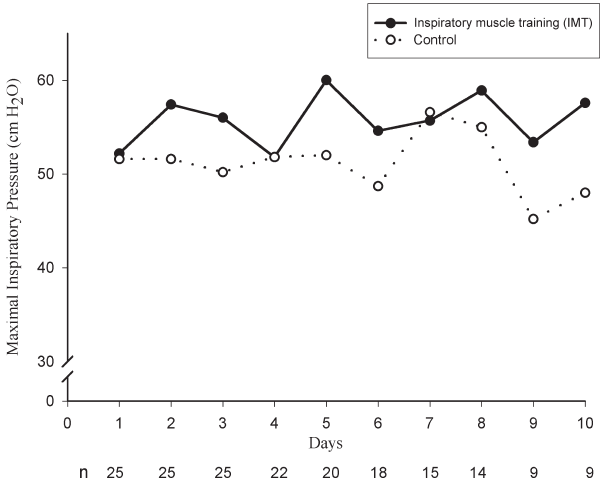
Figure 1 - Daily evolution of maximal inspiratory pressure in the first 10 days of mechanical ventilation. The value of each day represents the mean maximal inspiratory pressure in each group. The daily number of patients in each group remaining in the study recorded below the